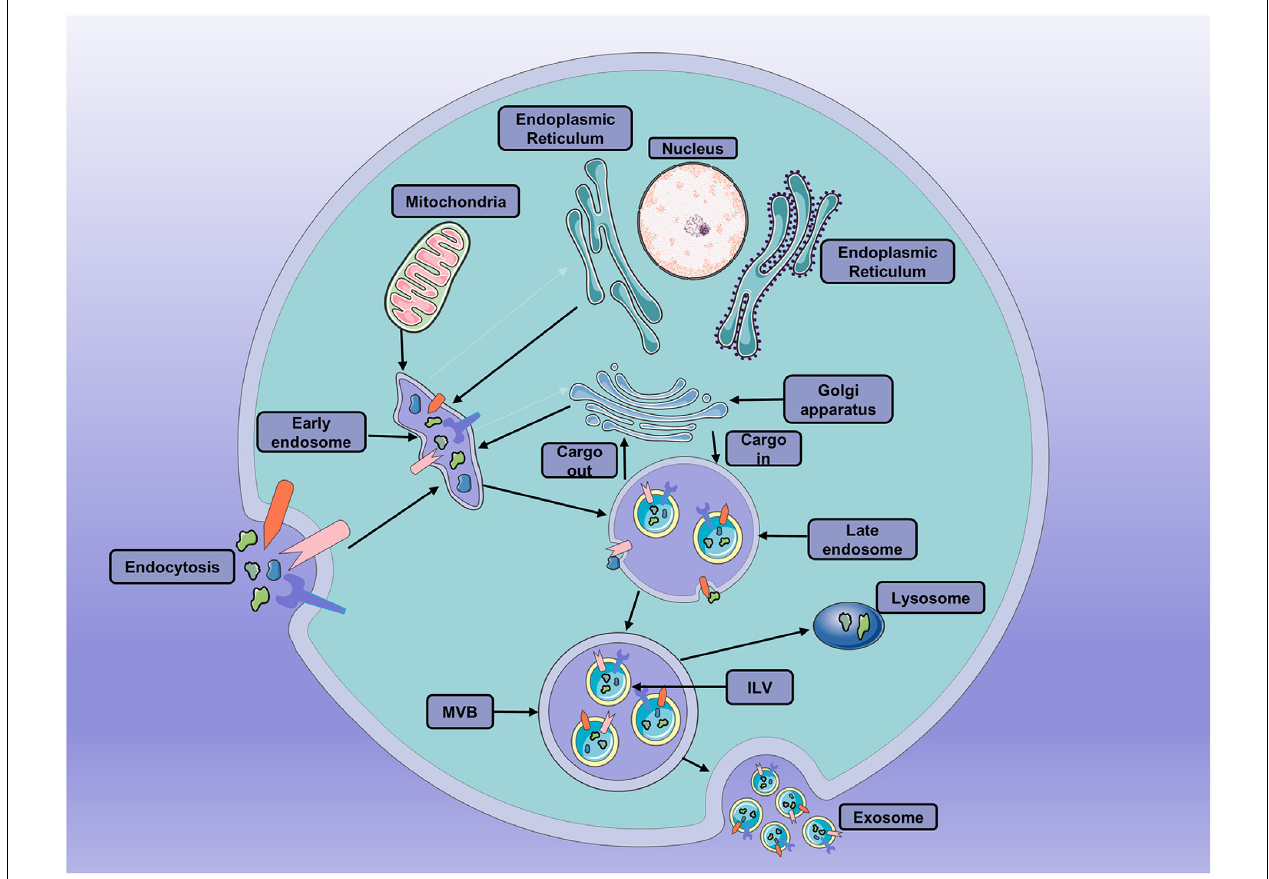
FIGURE 1 | The processes of exosomes formation, secretion and fusion. Early invagination of the endosome membrane allows intracellular components to be engulfed in vesicular intraluminal vesicles (ILVs). Then, the late endosomes become multivesicular bodies (MVBs) after the selective integration of substances by early endosomes. MVBs can either fuse with the plasma membrane and then release ILVs as exosomes into the extracellular space or fuse with lysosomes or autophagosomes to be